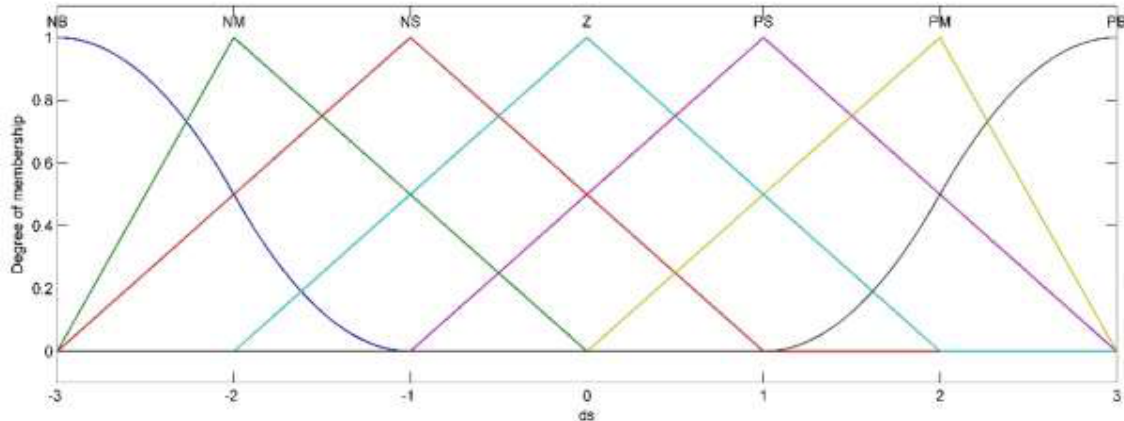
Figure 5. The membership functions of the output variable.